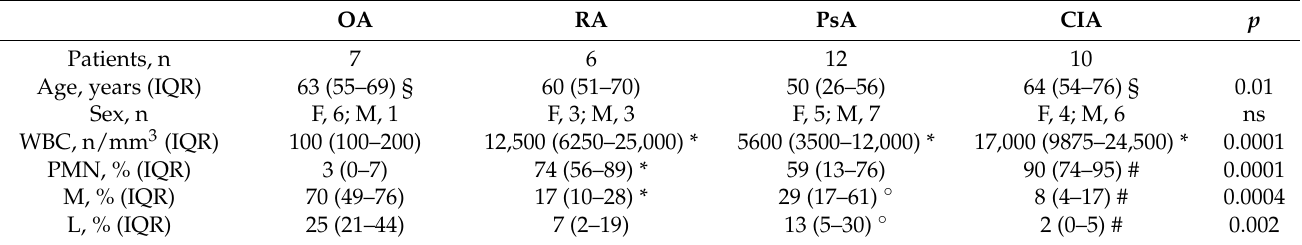
Table 1. Characteristics of the patients included in the study and their synovial fluid. OA RA